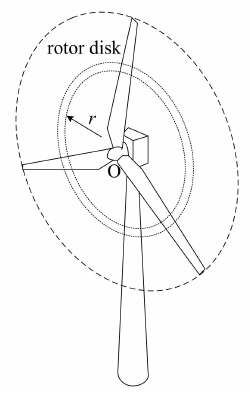
Figure 1. Wind turbine schematic